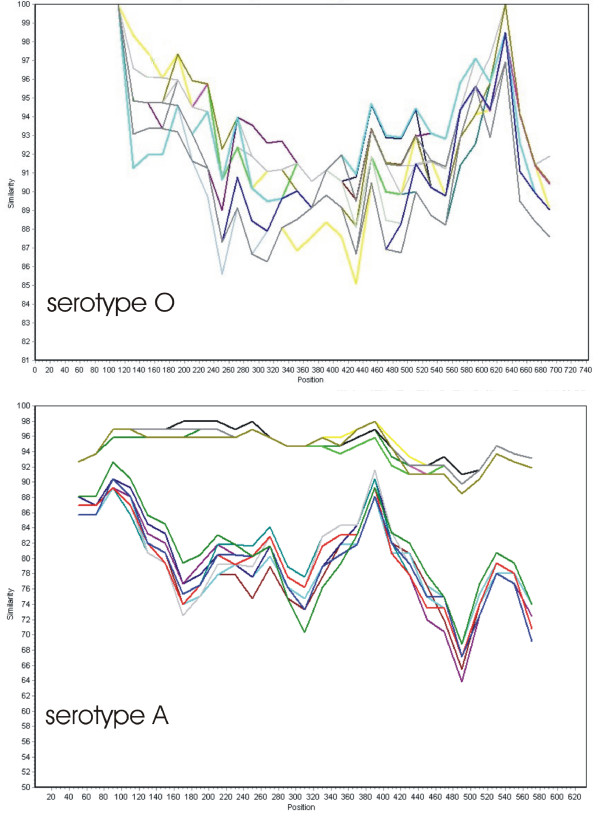
Similarity plot of the 1D nucleotide sequence from the Turkish serotypes O (upper panel) and A (lower panel) obtained in this study. Each coloured line indicates a single FMDV nucleotide sequence.